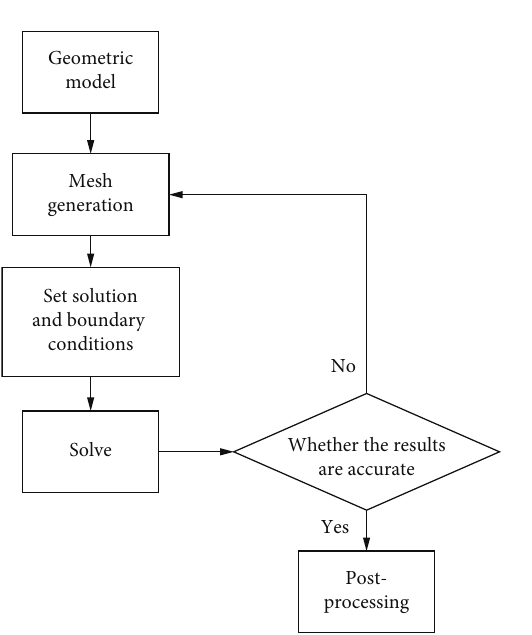
Figure 12: CFD fl ow